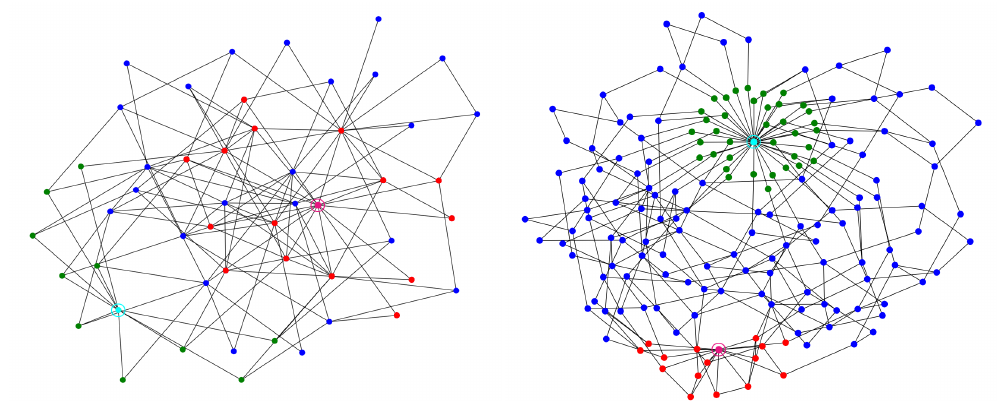
Figure 3. Graph G BA of ( left ) and graph G ER of ( right ). In cyan, and with a circle around the G 1 G 2 source s , in magenta and with a circle around the sink t , in green the nodes connected to s , and in red the nodes connected to t . All the other nodes are in